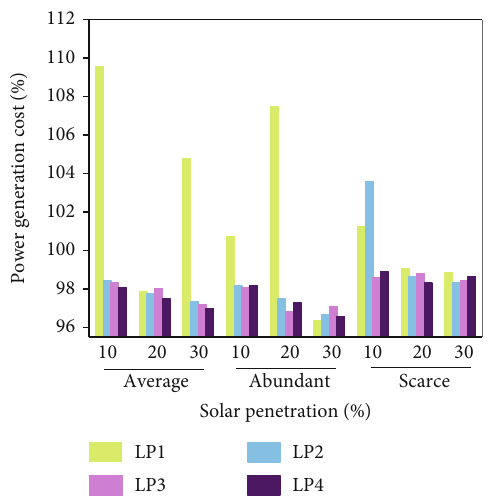
Figure 3: Power generation costs for the 24 h DEDs of the various load pro fi les (LPs) under average, abundant, and scarce solar resource conditions.